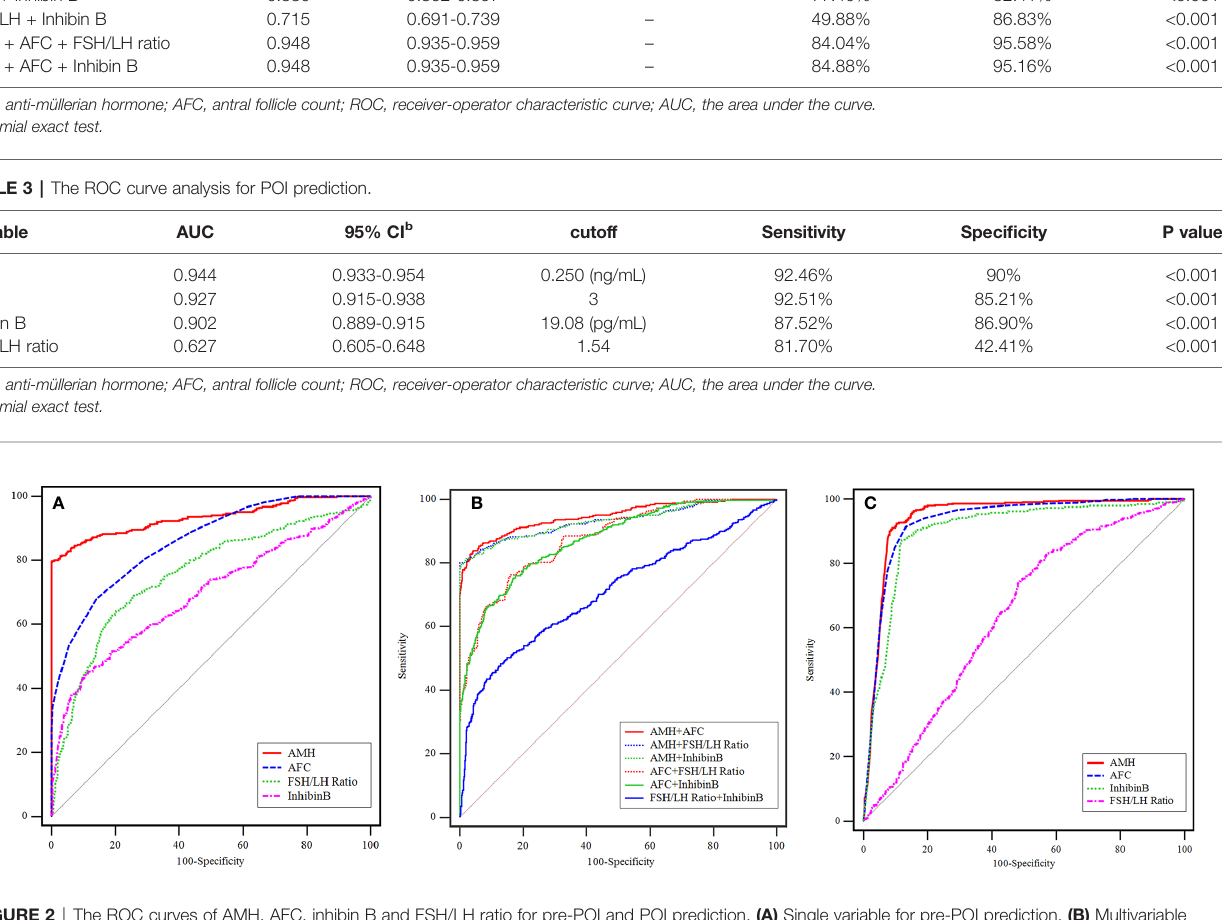
FIGURE 2 | The ROC curves of AMH, AFC, inhibin B and FSH/LH ratio for pre-POI and POI prediction. (A) Single variable for pre-POI prediction. (B) Multivariable models for pre-POI prediction. (C) Single variable for POI prediction.